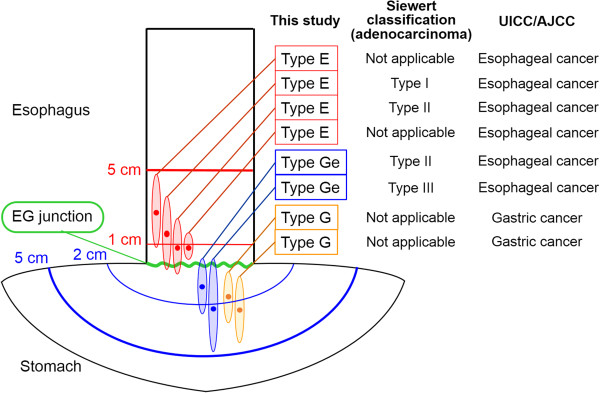
Tumor classification. We categorized tumors near the EGJ into four types according to its location and main histological type. Categorization criteria were: (i) squamous-cell carcinoma with epicenter in the esophagus within 5 cm from EGJ (type E (SQ)); (ii) adenocarcinoma with epicenter in the esophagus within 5 cm from EGJ (type E (AD)); (iii) any histological tumor with epicenter in the stomach within 5 cm from EGJ, with EGJ invasion (type Ge); (iv) any histological tumor with epicenter in the stomach within 5 cm from EGJ, without EGJ invasion (type G). Type E (SQ), E (AD) and Ge tumors were categorized as esophageal cancer; type G tumor was categorized as gastric cancer by the American Joint Committee on Cancer/International Union Against Cancer (AJCC/UICC) Cancer Staging Manual. Siewert type I and III tumors were categorized as type E (AD) and Ge tumors, and Siewert type II tumor was categorized as type E (AD) or Ge tumor in this study.